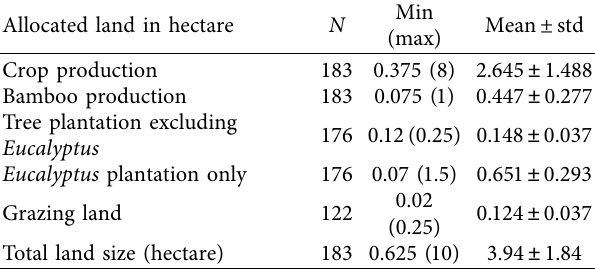
Table 3: Land allocation of the